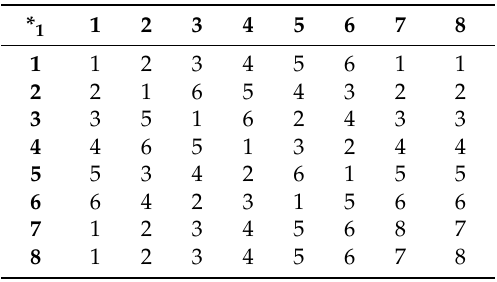
Table 11. The operation * 1 on non-commutative perfect NETG N 1